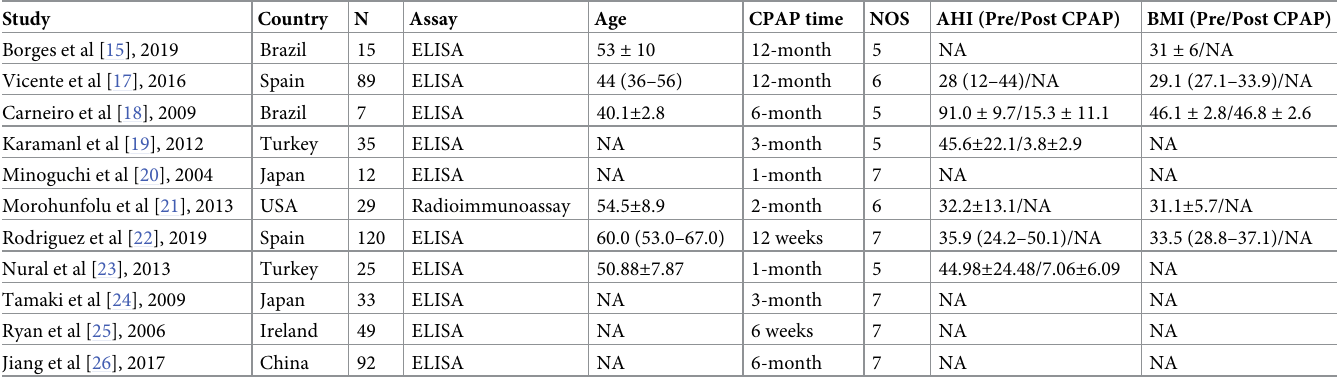
Table 1. Description of included studies.